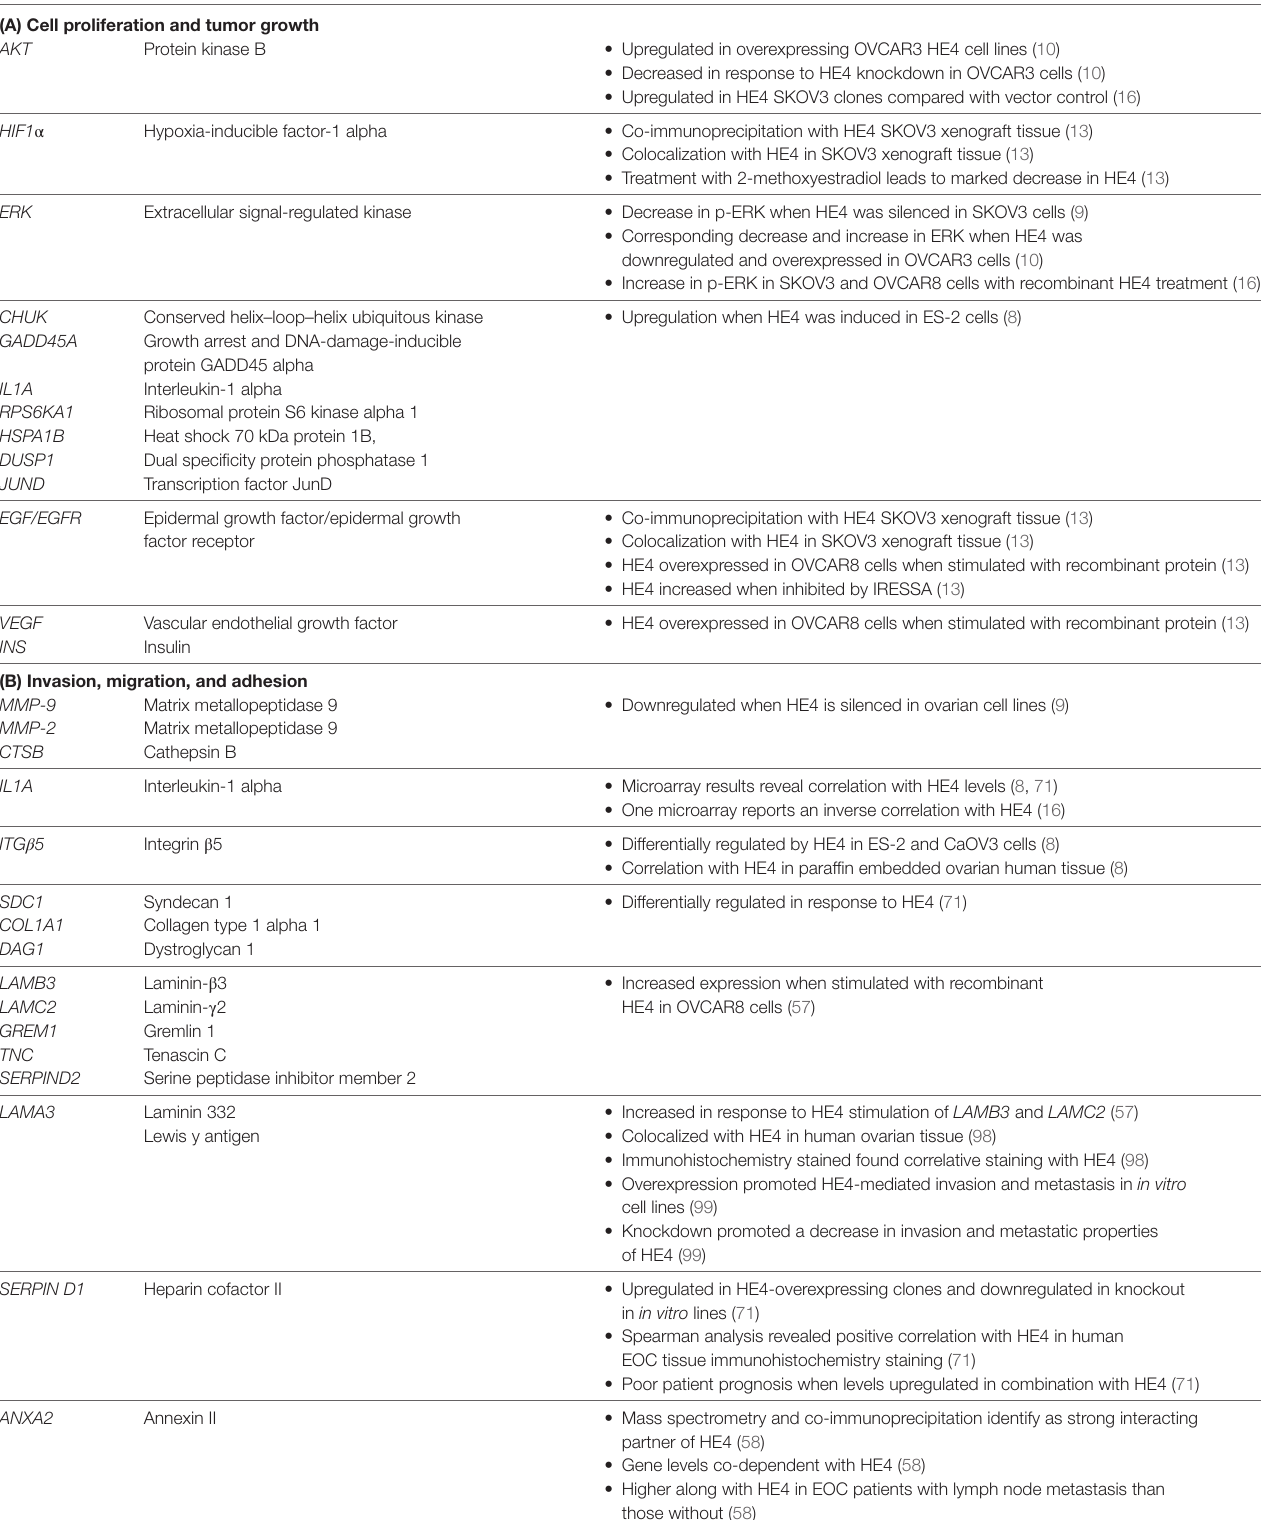
TABLe 1 | Summary of factors associated with human epididymis protein 4 (HE4) in epithelial ovarian cancer (EOC). Gene